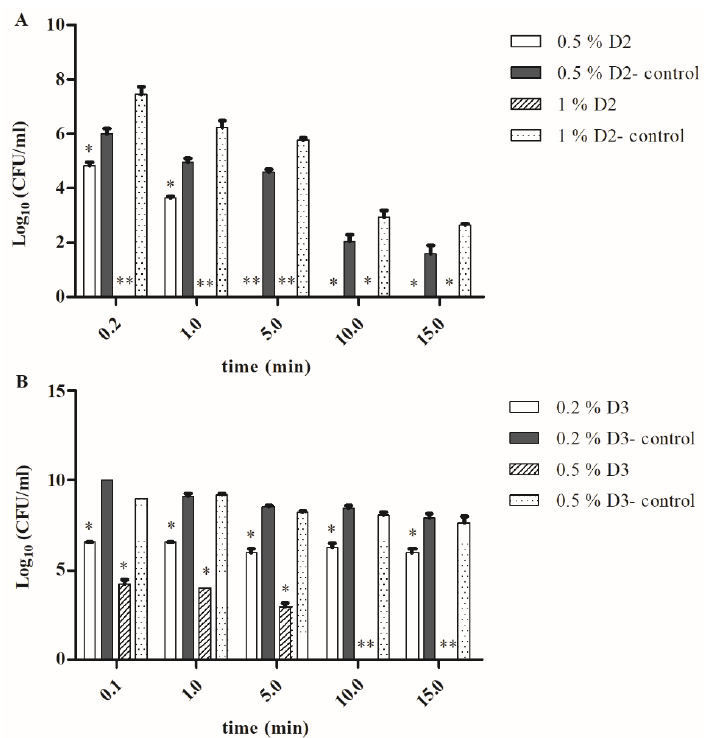
Figure 3. The bacterial viability of F. novicida grown in A. castellanii after treatment with ( A ): 0.5 and 1% D2. ( B ): 0.2 and 0.5% D3 for di ff erent time frames. A. castellanii was infected with F. novicida at a MOI of 10. After the incubation in amoeba, the intracellular bacteria were plated on a BCYE agar. The bacterial suspension (10 9 CFU / mL) of F. novicida grown in the amoeba was treated with 0.5 and 1% D2 or 0.2 and 0.5% D3 in a 1:1 ratio over di ff erent time periods: 10 s, 1, 5, 10 and 15 min. The numbers control samples. The agar-grown F. novicida suspension treated with D2 or D3 solution was used as